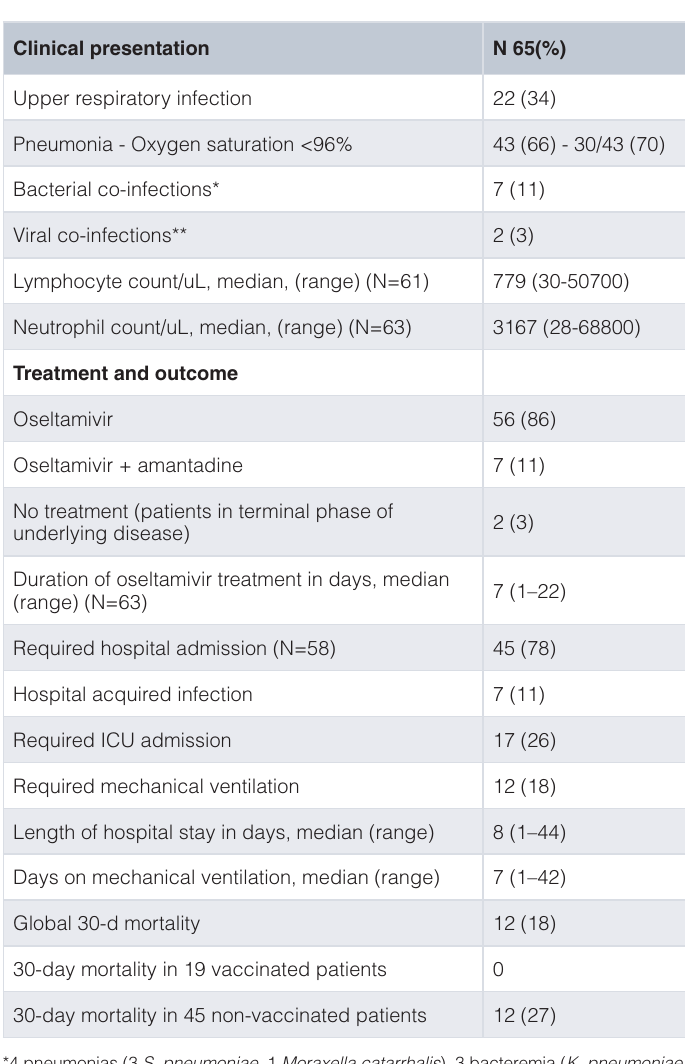
Table 1. Clinical presentation, treatment and outcome of cancer patients and stem cell transplant recipients with confirmed pandemic Influenza A H1N1 virus